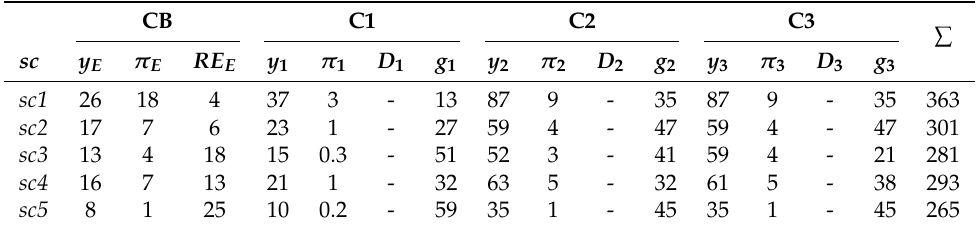
Table 14. Detailed objective function values, robustness experiment